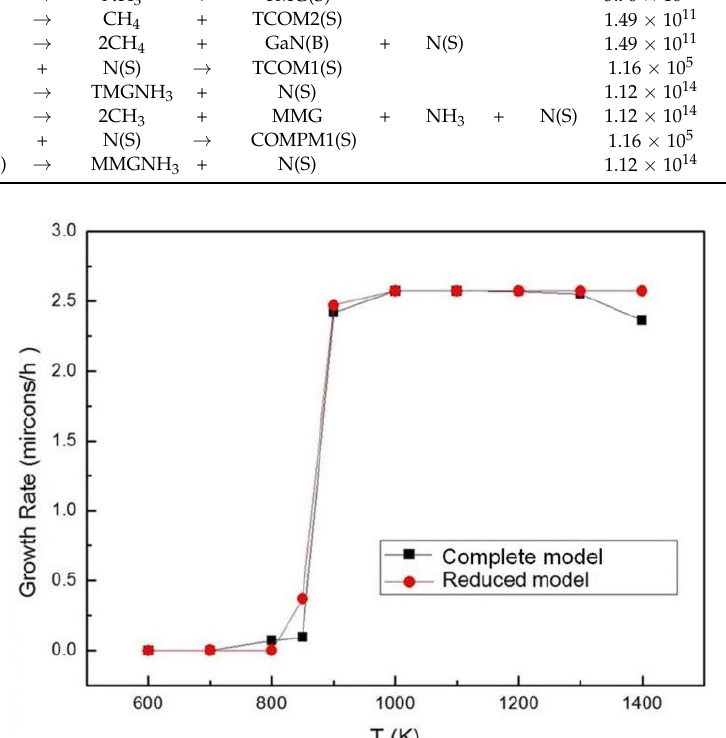
Figure 9. Complete model vs. the reduced model. Table 5. Surface mechanisms (Path 1 + Path 3) are considered for the reduced model.